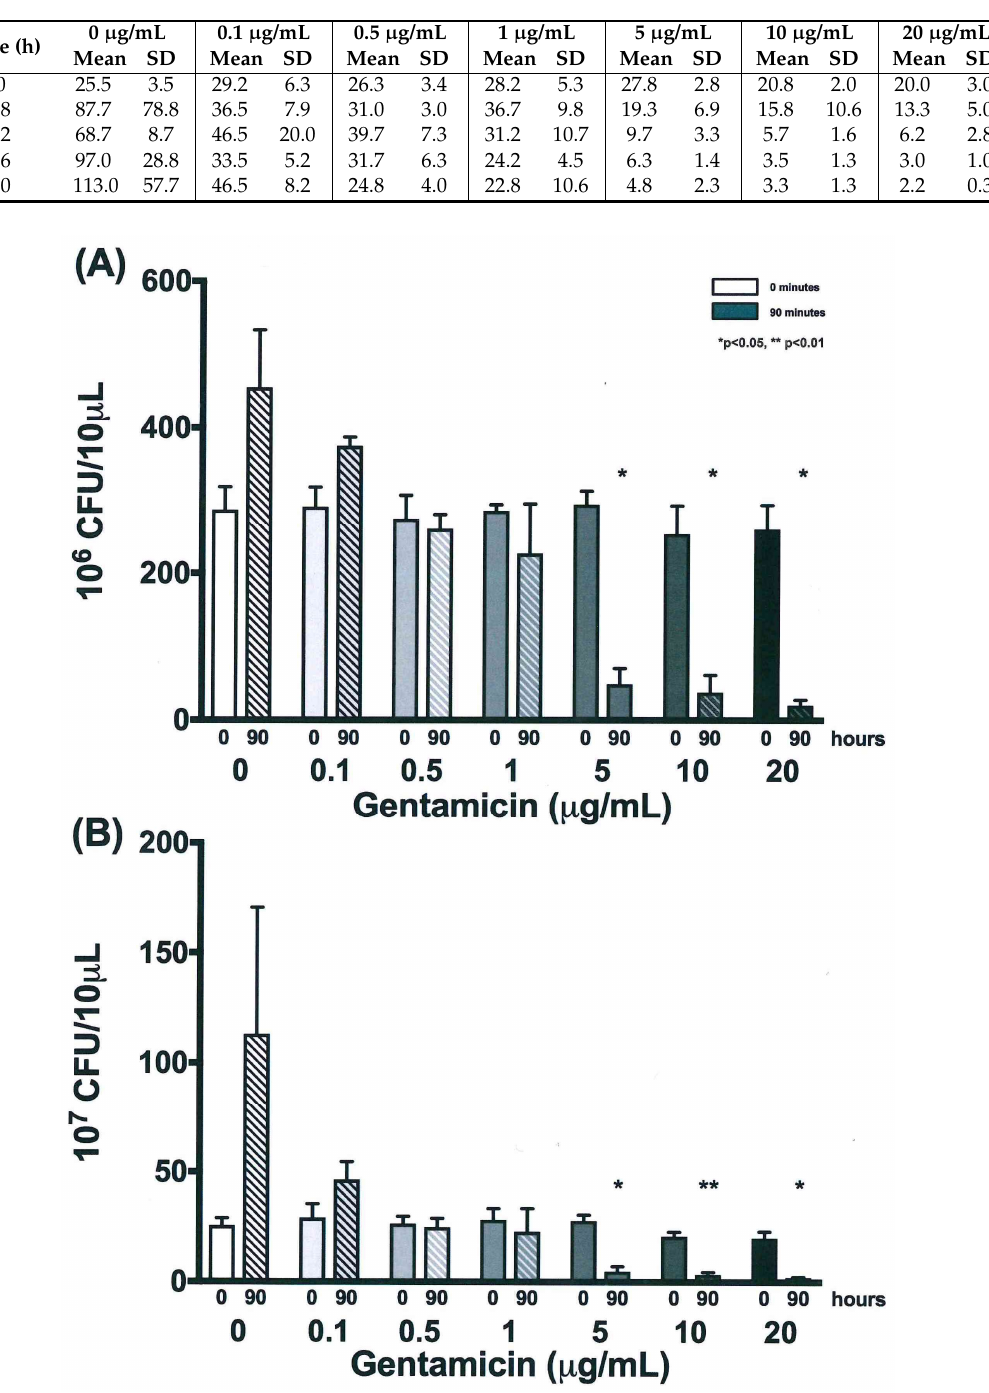
Table 3. Mean and standard deviation of bacterial growth (CFU) at 10 7 dilutions for M. avium with gentamicin treatment over 90 h, n = 3.